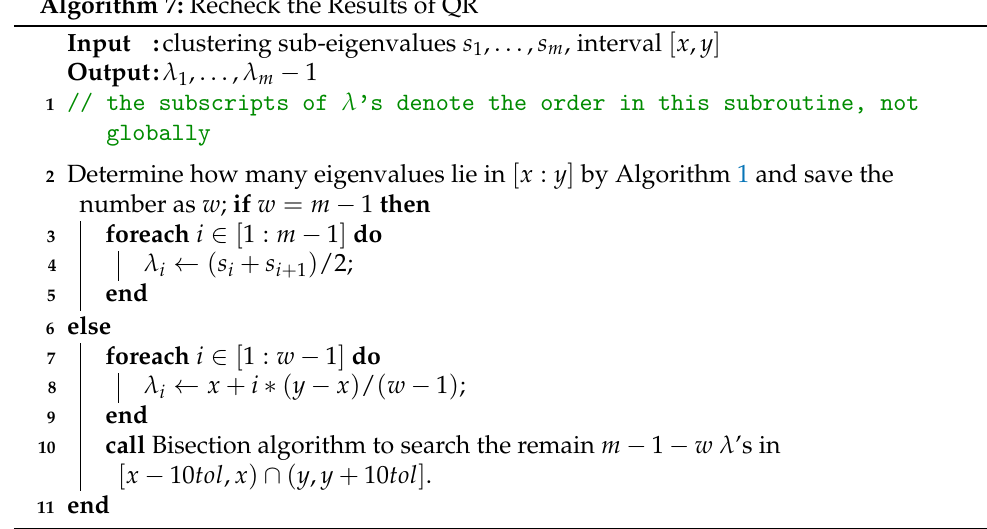
Algorithm 7: Recheck the Results of